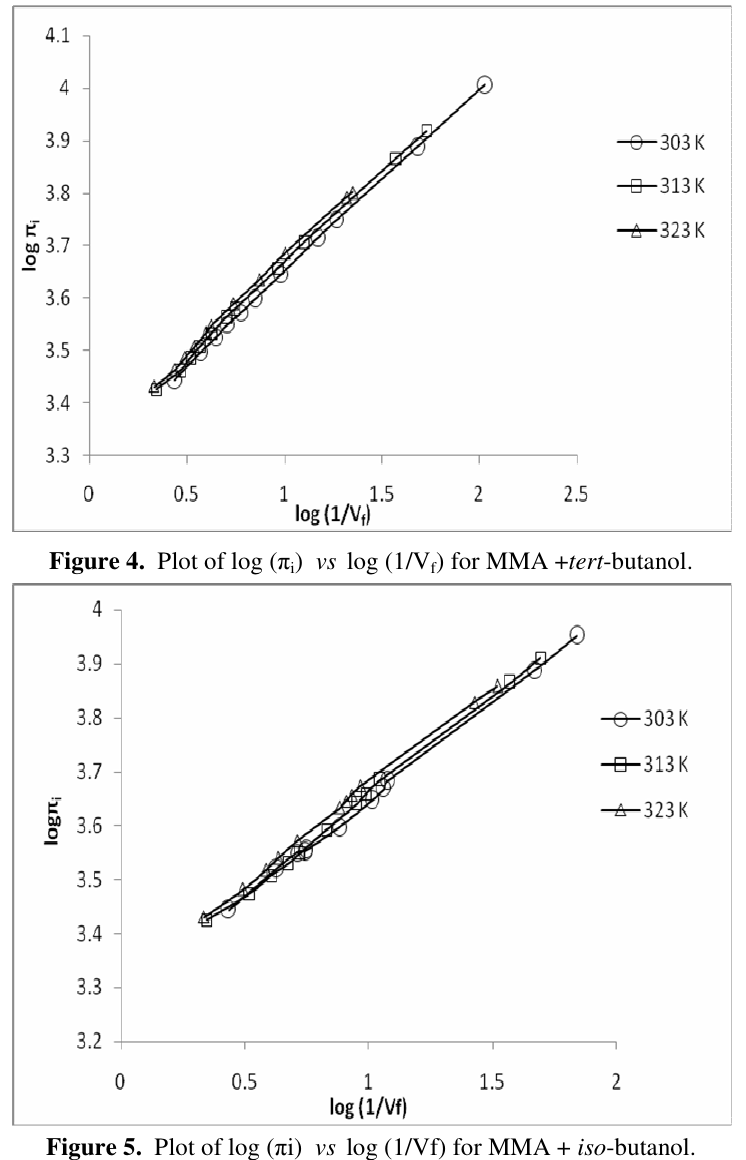
Figure 5. Plot of log ( π i) vs log (1/Vf) for MMA + iso